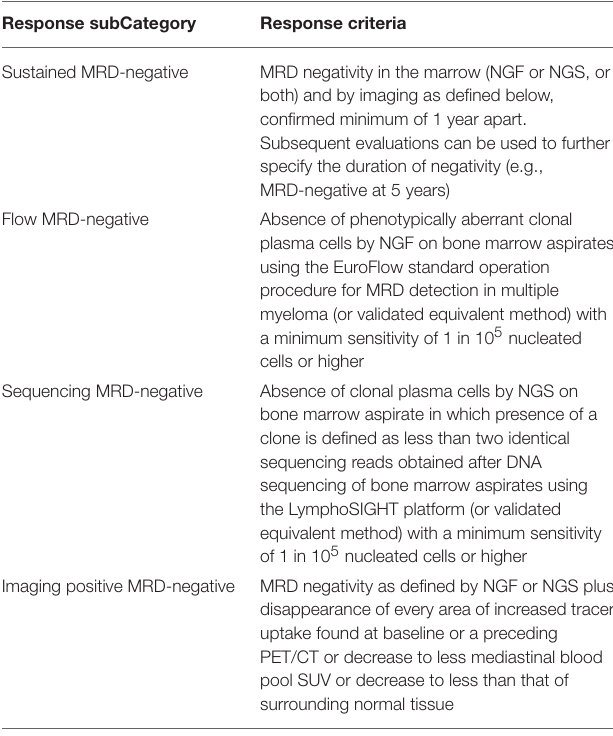
TABLE 1 | IMWG criteria of response for patients with